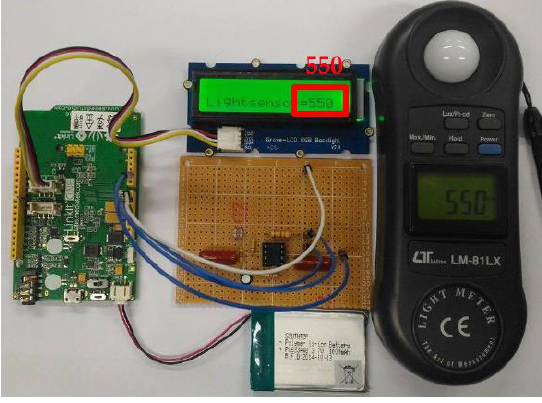
Figure 16. Ambient light sensor vs. photometer LM-81LX.